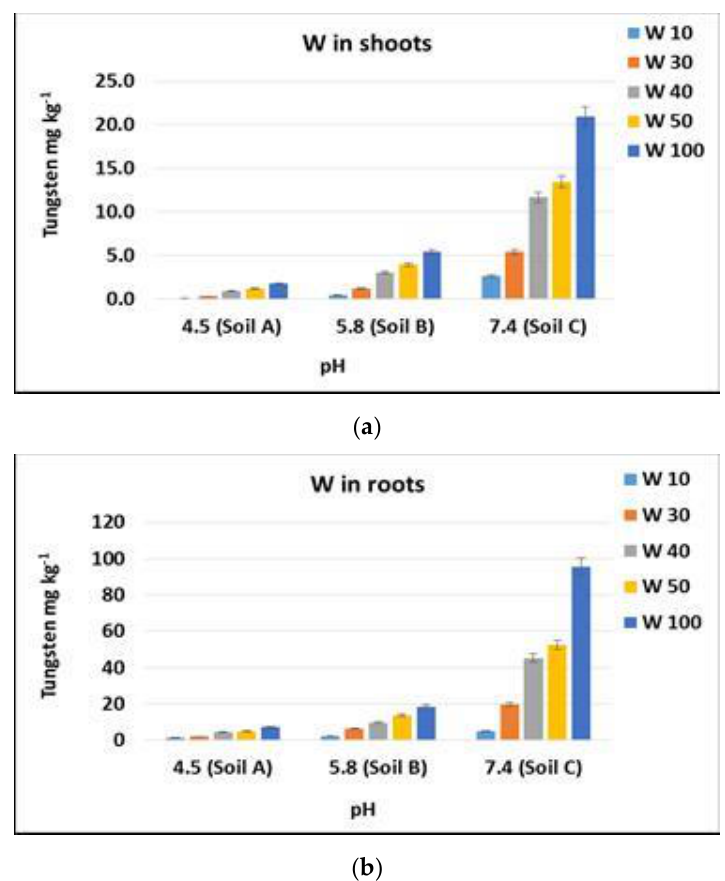
Figure 2. Mean values of tungsten concentrations in plants in relation to pH of the different soils. Bars indicate standard deviation. ( a ) shoots; ( b ) roots.